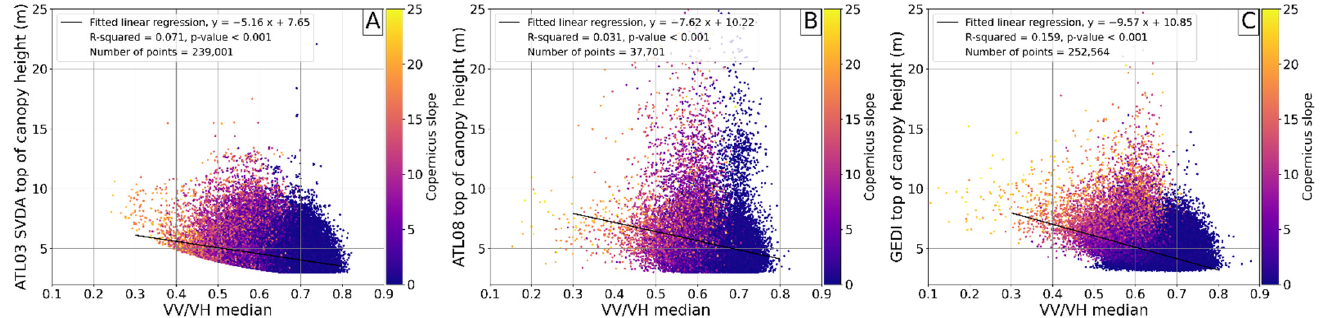
Figure 15. Canopy height from spaceborne lasers and Sentinel-1 VV/VH median relationships. ( A ) ATL03 SVDA canopy height and VV/VH median relationship, ( B ) ATL08 canopy height and VV/VH median relationship, and ( C ) GEDI canopy height and VV/VH median relationship. We note the weak, but statistically significant linear relation between VV/VH and canopy height measurements.